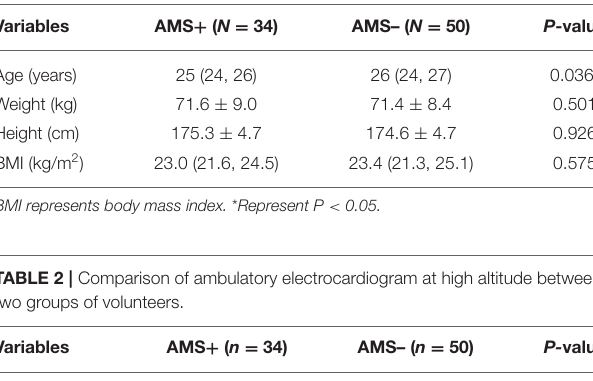
TABLE 1 | Demographic data of the subjects in two groups.